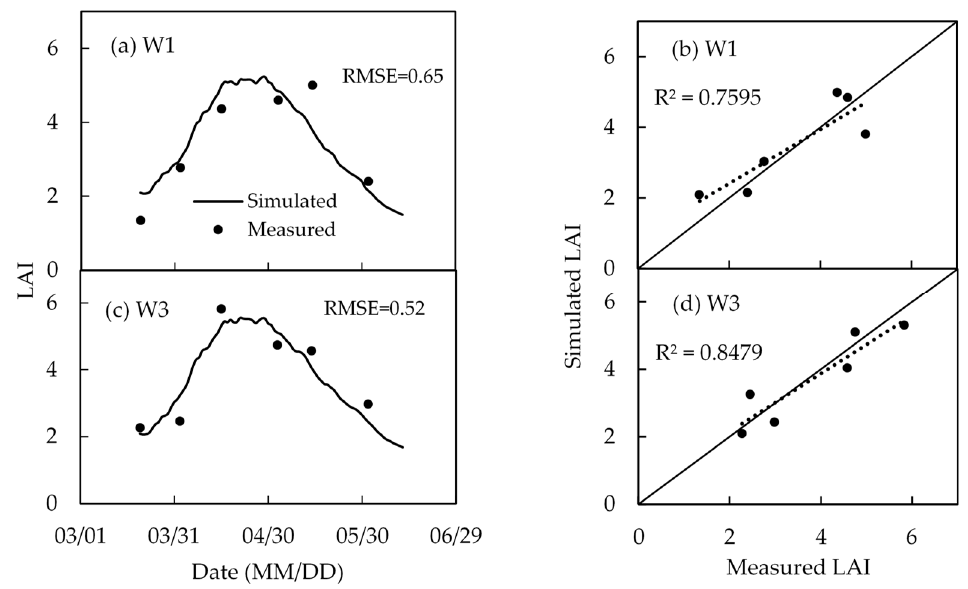
Figure 13. Comparison of simulated and measured LAI in validation treatments.